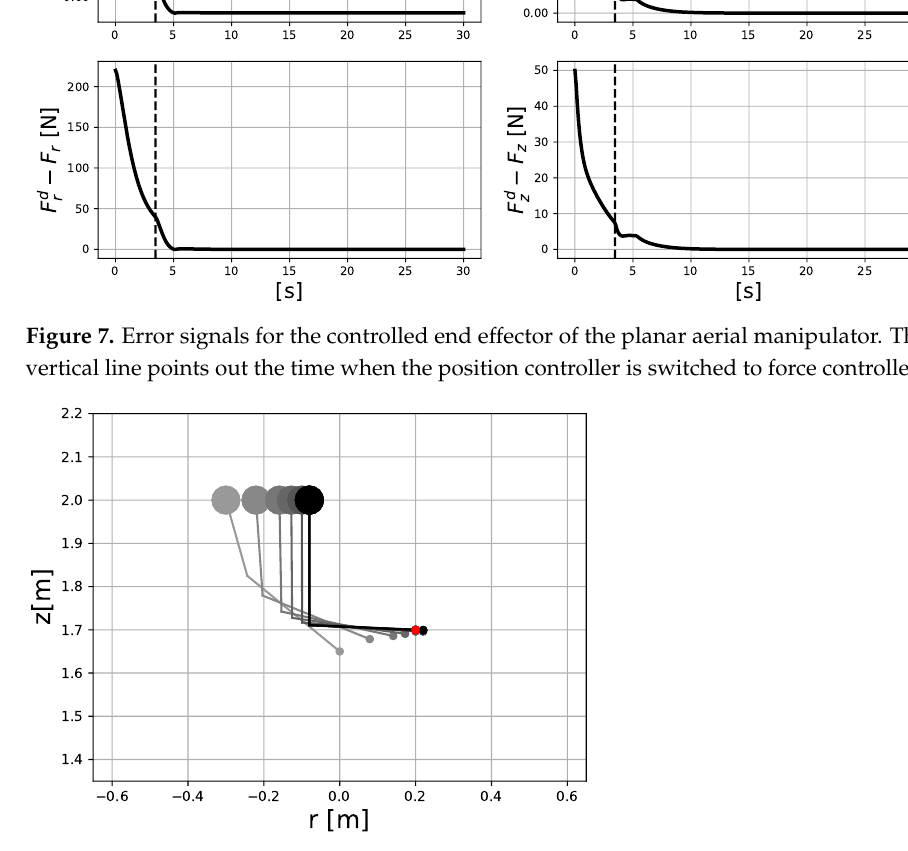
Figure 8. Cartesian-space trajectory of the planar aerial manipulator to the target force application